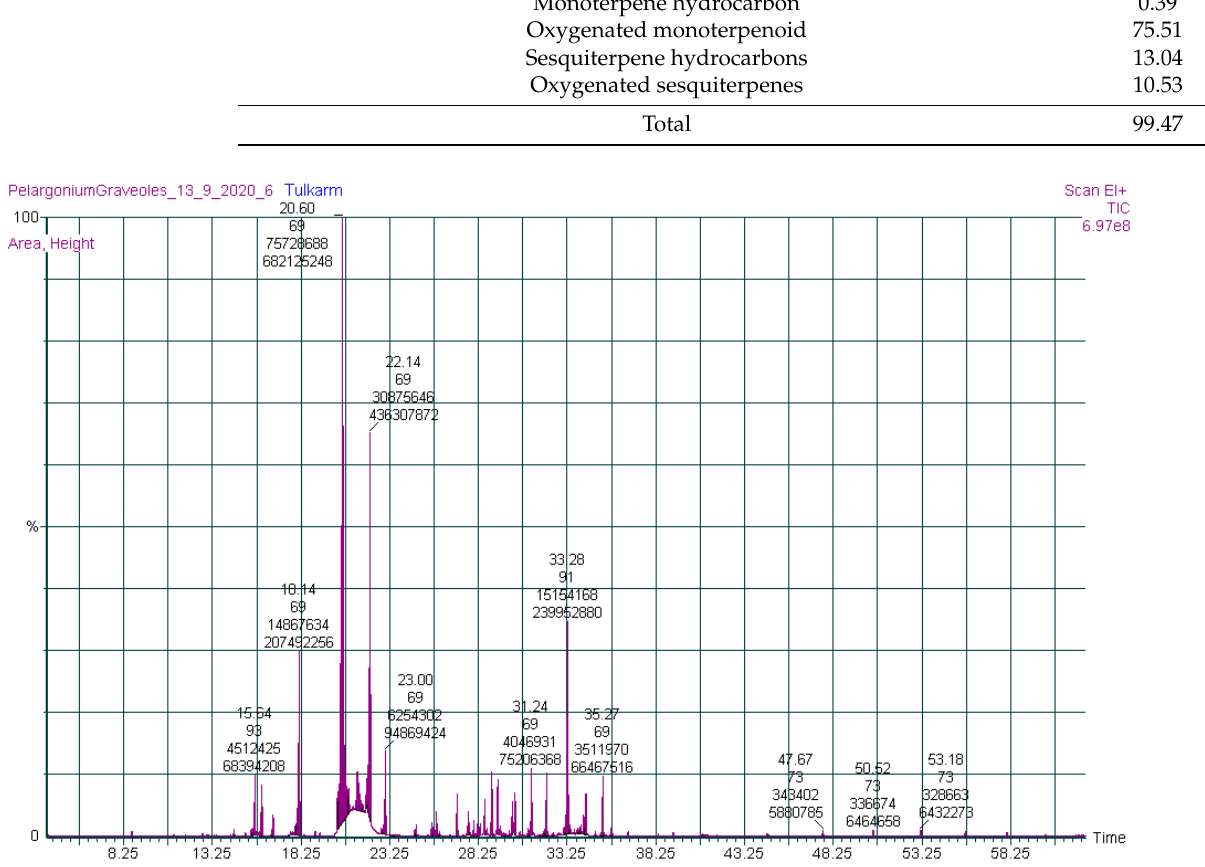
Figure 1. GC-MS chromatogram of PGEO. The retention time of the eluted peaks of the identified phytochemical compounds was tested statistically using a one-sample t -test and the results indicated no statistical difference ( p > 0.05) with the injected hydrocarbon standards. However, when the per- centage of the PGEO constituents was tested statically using ANOVA statistical test; the results indicated a statistical difference ( p < 0.05) between the phytochemical constituents of the EO. 2.2. Antioxidant Activity In this study, the PGEO showed strong anti-DPPH radical activity (IC 50 = 3.88 ± 0.45 µg/mL) and had 48.45% of the antioxidant potential of the commercial used antioxidant compound Trolox (IC 50 = 1.88 ± 0.45 µg/mL), as presented in Table 2. Table 2. The IC 50 (µg/mL) for PGEO against DPPH, lipase, α -amylase, α -glucosidase, COX-1, and COX-2, as well for the positive controls. Antioxidants, Target Metabolic Enzymes, Can- cer Cells Lines, and COX